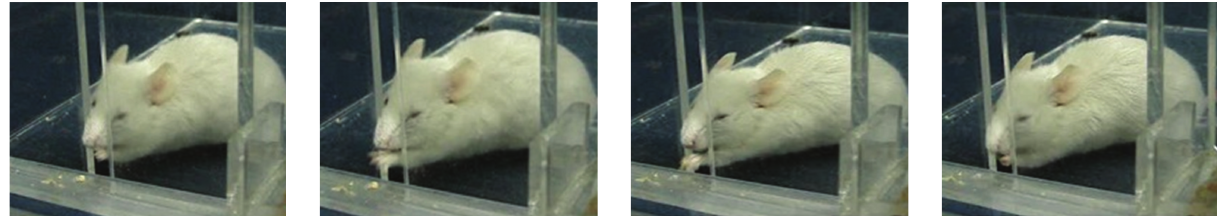
Figure 2: Representative still frames of a control mouse captured during limb transport and limb withdrawal. The control animals advanced their forelimb through the slot and extended their digits, and they also supinated their paw to present the food to the mouth and extended their digits to release the food into the mouth (see text for detailed description.)